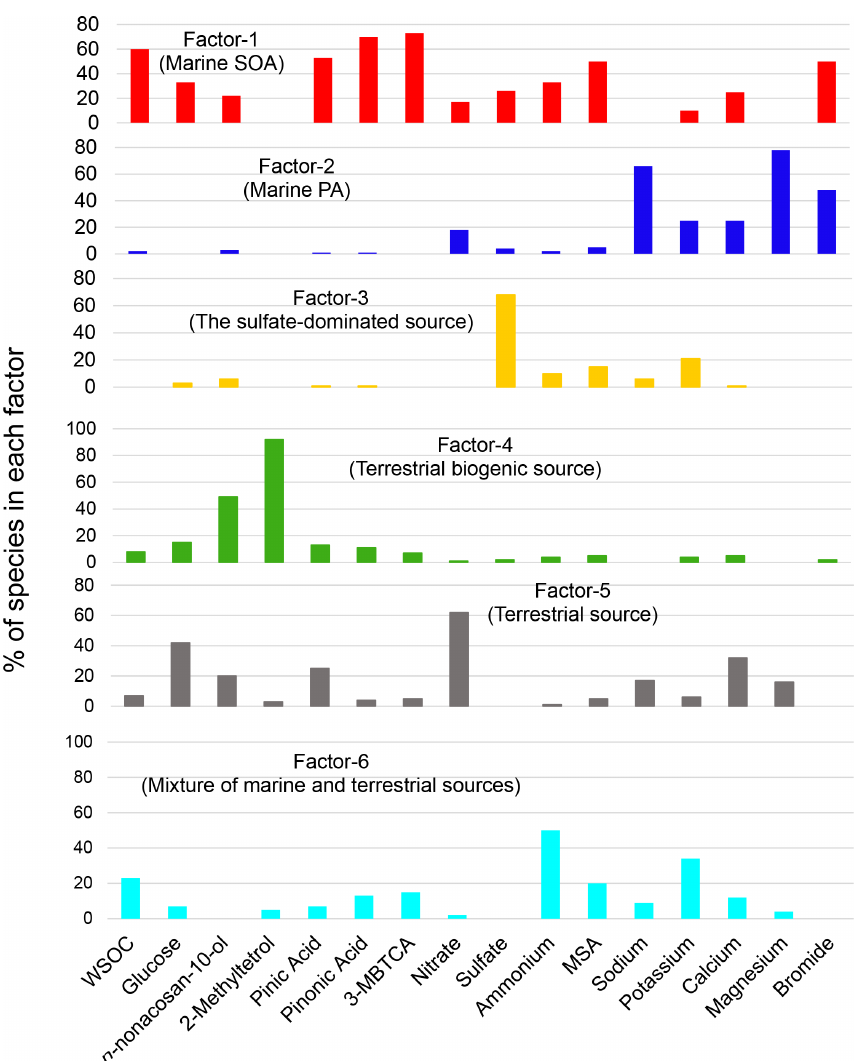
Figure 7. Six factor profiles for the entire campaign derived from PMF analysis. The percentage of chemical species in each factor is